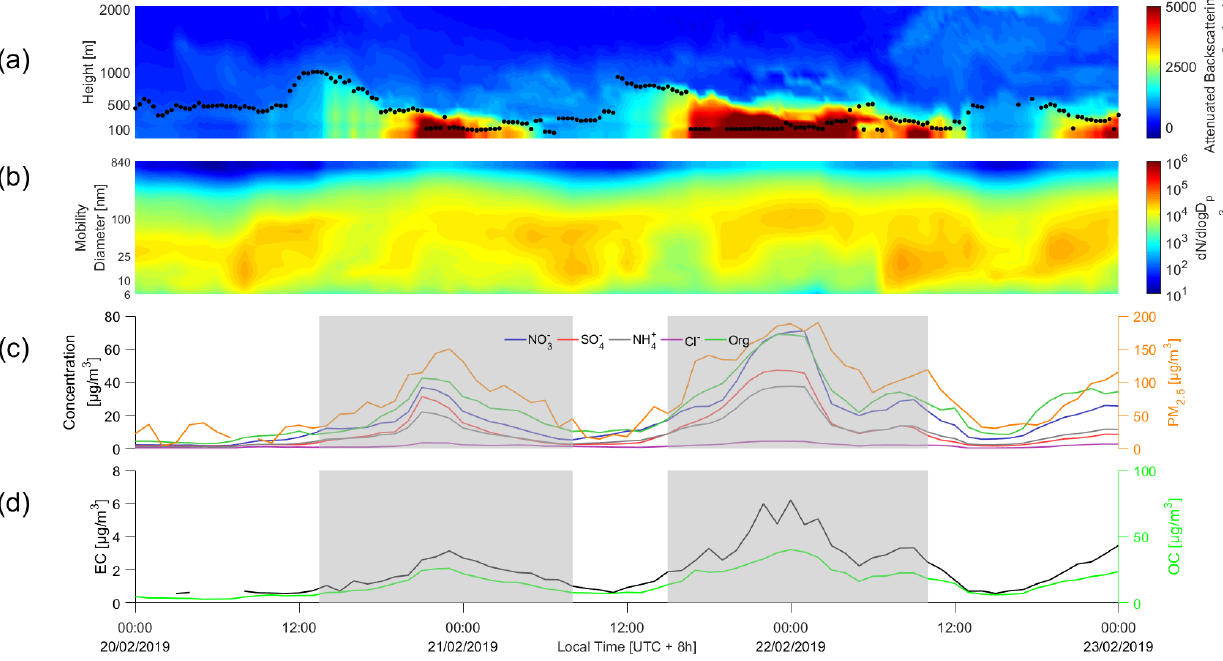
Figure 2. Time series of (a) attenuated backscattering coefficient and mixing layer height and (b) particle number concentration distribution (PNSD), (c) chemical composition and PM 2 . 5 mass concentrations and (d) elemental carbon (EC) and organic carbon (OC). The haze periods are marked by the shaded